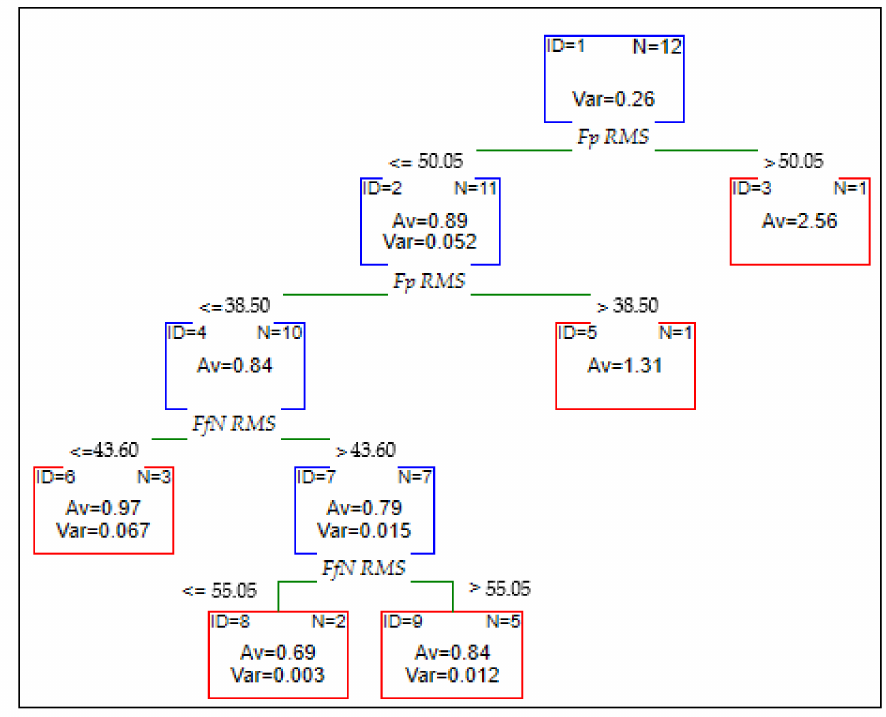
Figure 14. Structure of CART.